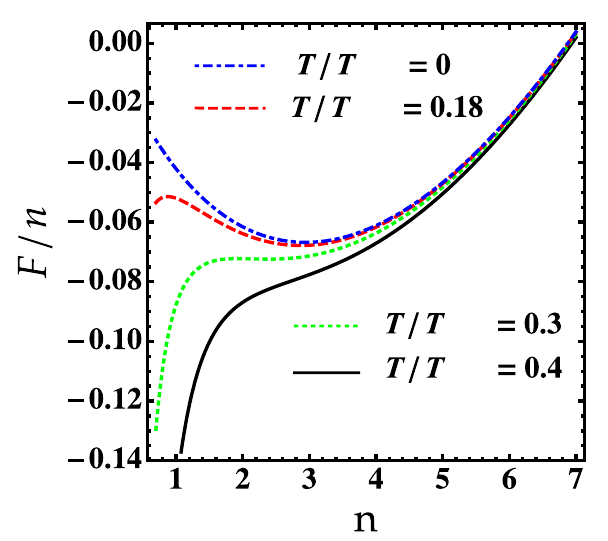
Figure 3. The free energy F / n as a function of the density for different values of temperature, T / T BKT . Parameters are: g = 0.45 , g 12 = 0.2 and ǫ 0 = 4.8